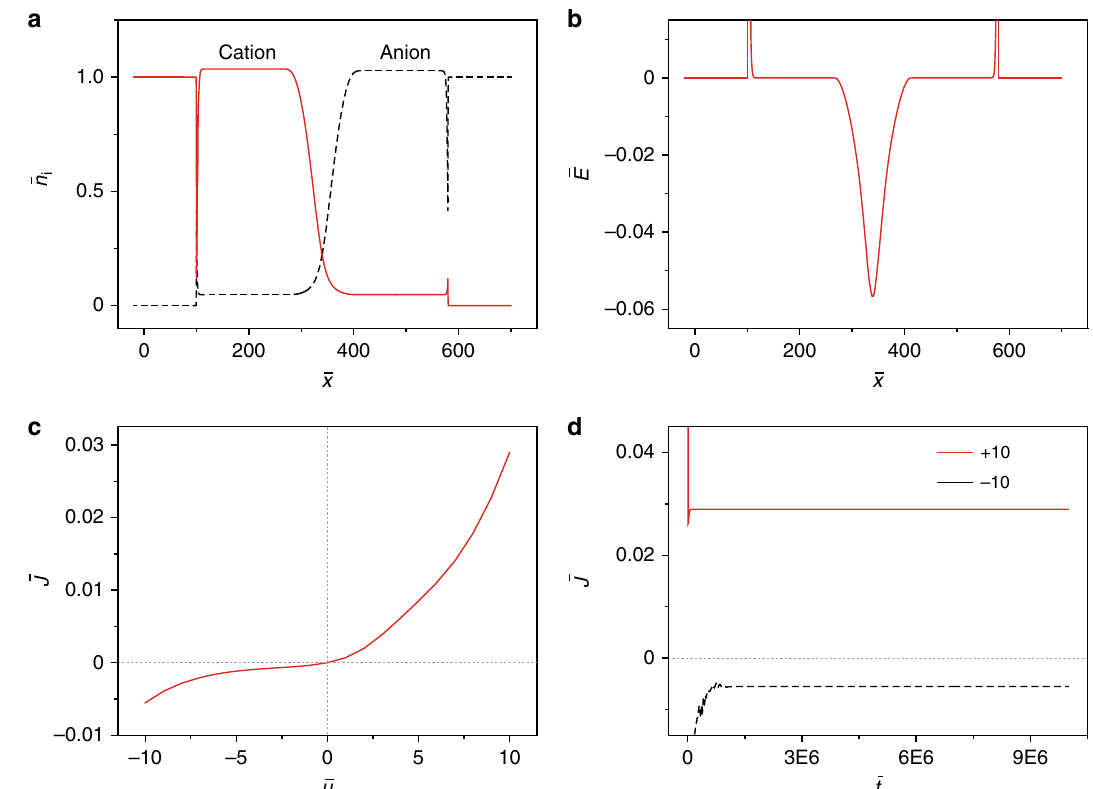
Fig. 3 Modelling of the current recti fi cation. a Spatial distribution of tetramethyl ammonium cations (red) and chloride anions (black dash) after equilibration in the absence of applied bias. b The internal electric fi eld at the junction in the absence of applied bias. c , d The steady state current – voltage characteristics ( c ) and the transient current responses ( d ) at either positive or negative constant (2) the current recti fi cation (blue curve, right axis of Fig. 2c), plotted in real time and stabilized at a ratio of approximately 6, is the intrinsic characteristics of the graphene pn diode where the